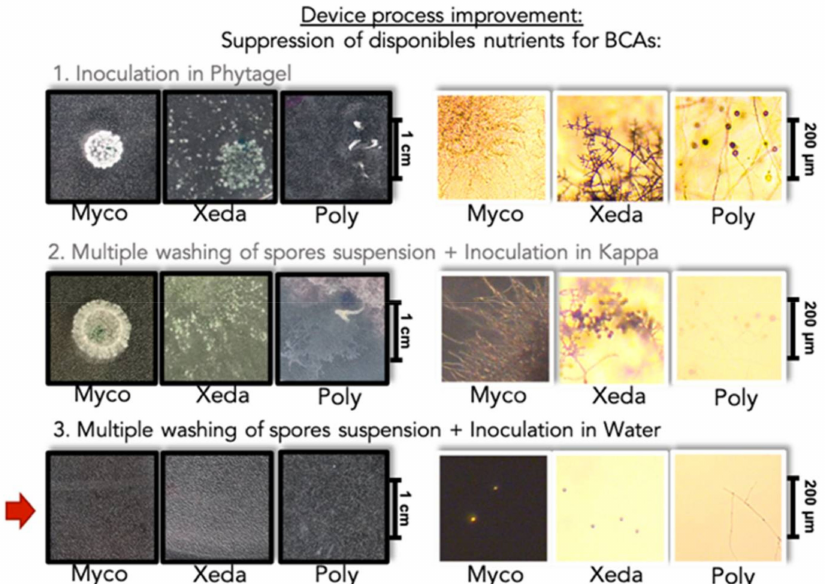
Figure 2. Experimental device process improvement. To ensure that BCAs no longer had sufficient nutrients to grow in the absence of pathogens, various improvements were made based on devices proposed by Balhausen et al. (2015) [22]. All BCAs were directly inoculated on different minimal media without pathogen to verify the absence of growth (( 1 ) Phytagel, ( 2 ) Kappa, ( 3 ) Water). Optical microscope images framed in black were obtained at macroscopic scale and those framed in white were obtained at microscopic scale after 20 days of incubation. Only ( 3 ): multiple washing of spore suspension followed by inoculation in water permitted to note the absence of development of BCAs without nutrients. The red arrow indicates that this mode of inoculation has been chosen. Myco: Mycostop ® , Xeda: Xedavir ® , Poly: Polyversum ®